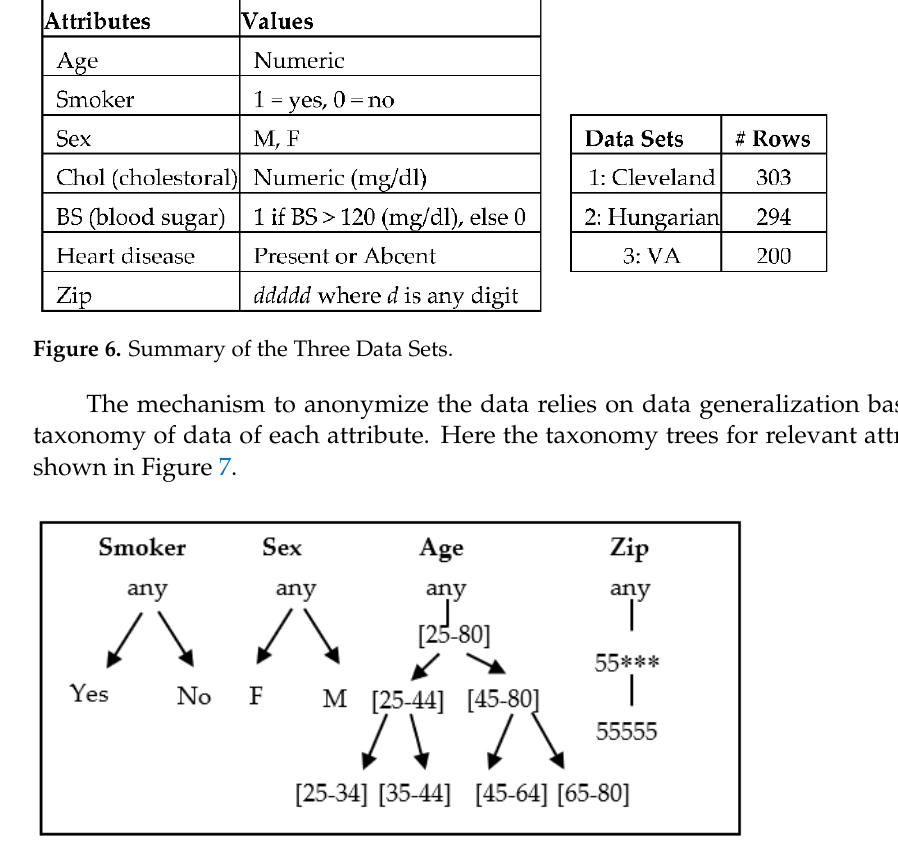
Figure 7. Taxonomy Trees.